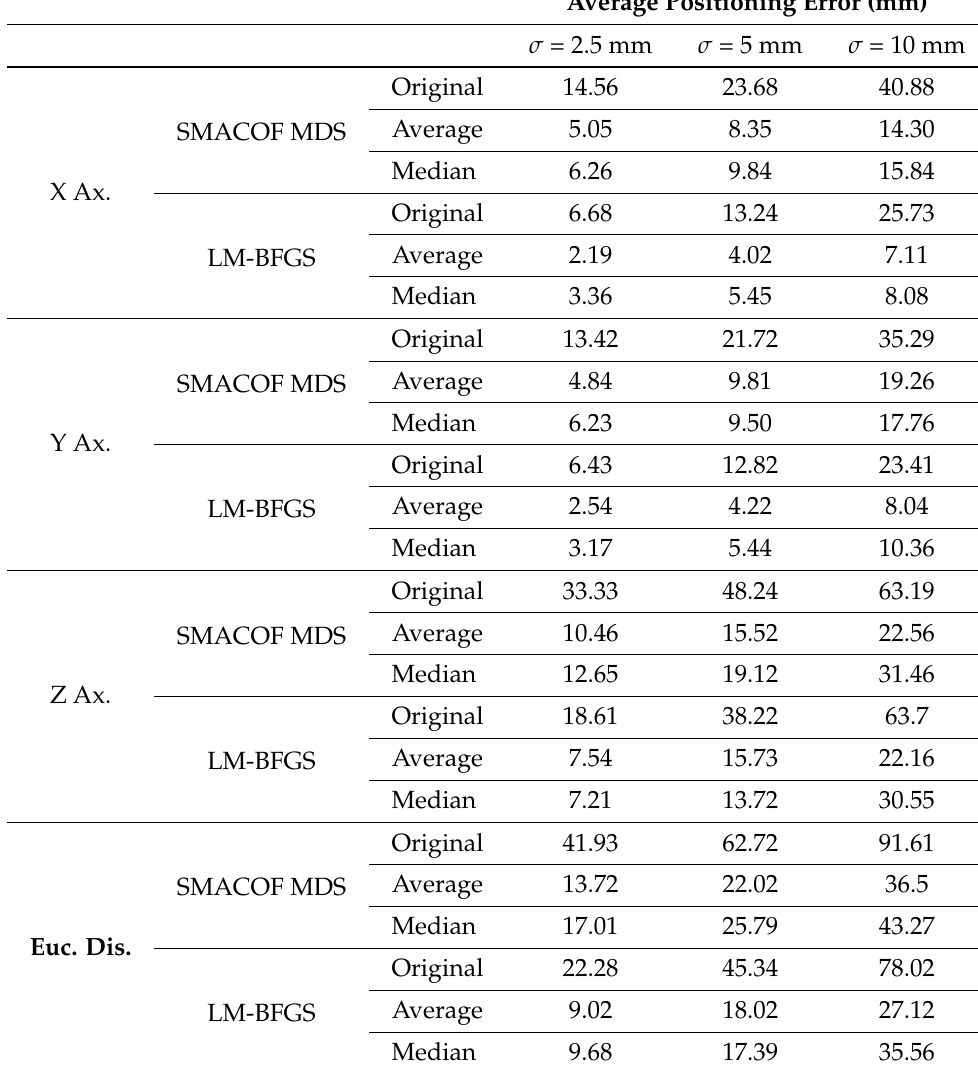
Table 4. Average trajectory error for the circle XY gesture, with no smoothing (Original) and with 11th order ( M = 11) moving-average (Average) and moving-median (Median) smoothing filters, for SMACOF MDS and LM-BFGS optimization